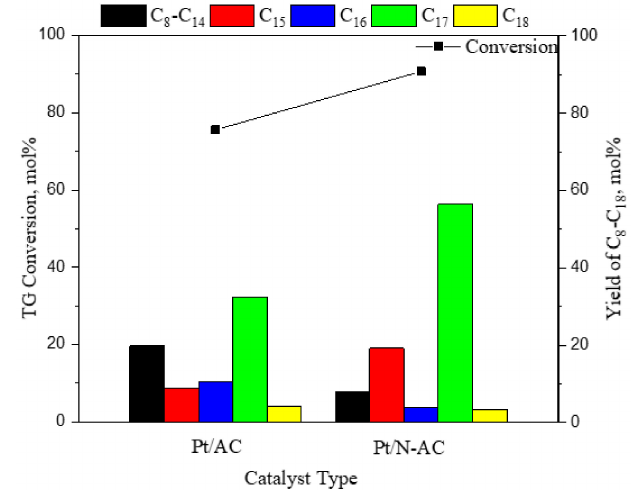
Figure 8. Conversion of triglycerides and yield of C 8 –C 18 products over Pt / AC and Pt / N-AC